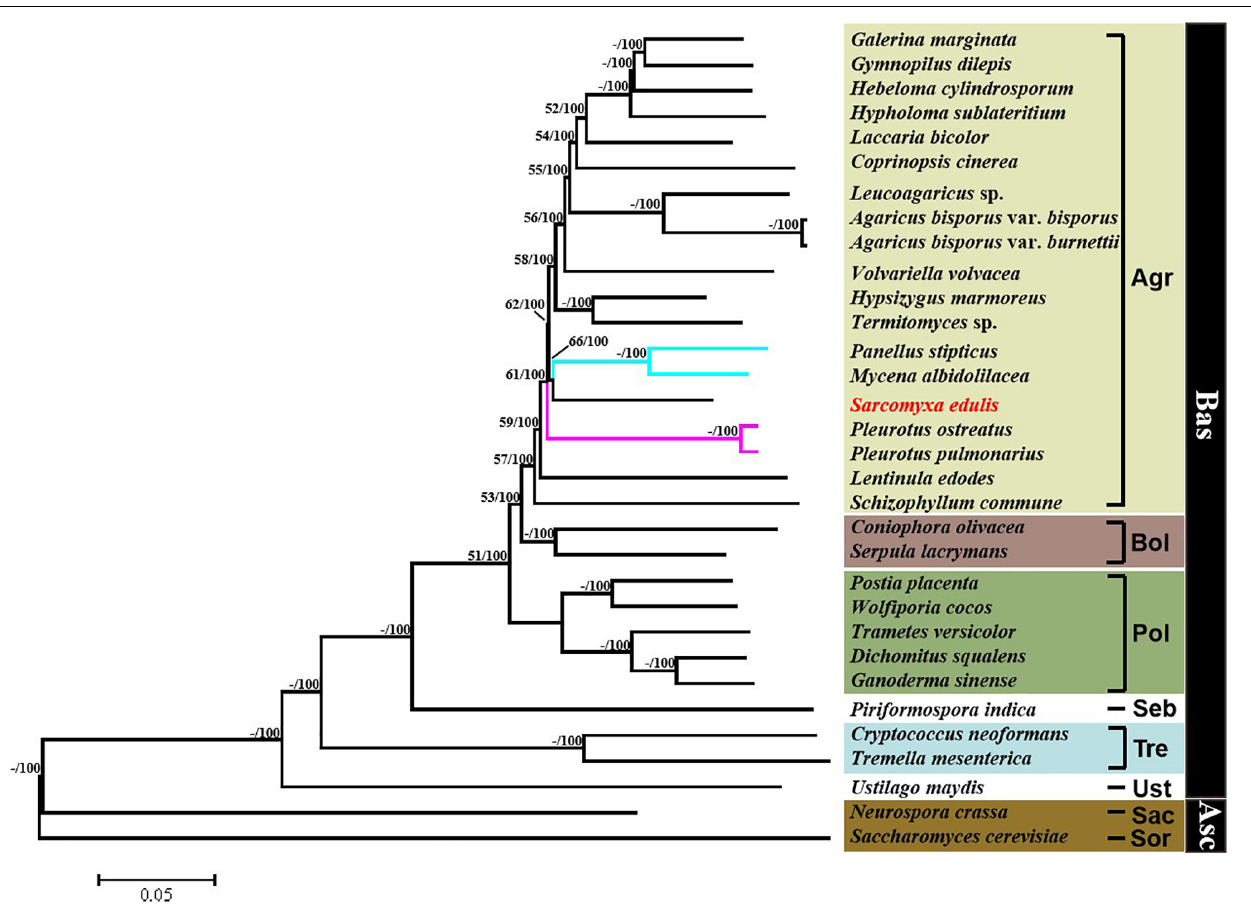
FIGURE 7 | Phylogenetic tree of Sarcomyxa edulis and 31 other fungal species. Maximum likelihood and neighbor-joining above 50% were placed close to topological nodes and separated by “/”. The bootstrap values below 50% were labeled with “-”. Asc, Ascomycota; Bas, Basidiomycota; Sor, Sordariales; Sac, Saccharomycetales; Ust, Ustilaginales; Tre, Tremellales; Seb, Sebacinales; Pol, Polyporales; Bol, Boletales; and Aga, Agaricales.